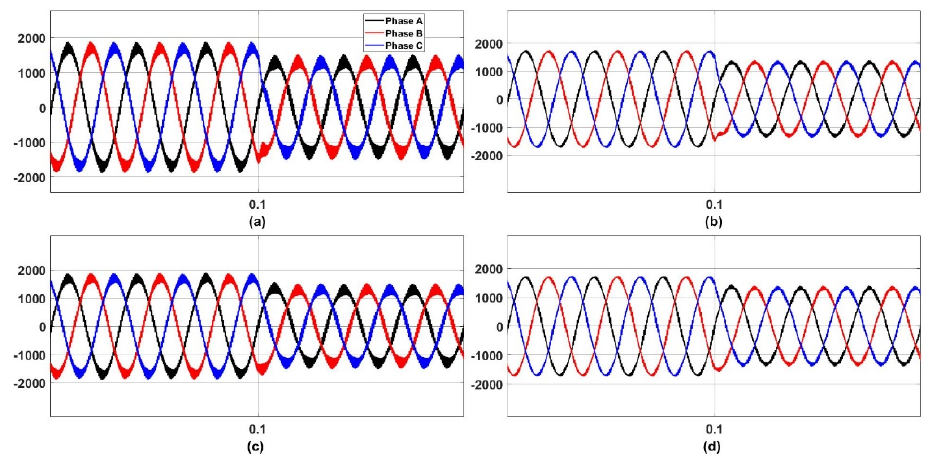
Figure 20. Three-phase pcc currents in a balanced voltage swell in the case of ( a ) 2L- αβ , ( b ) 3L- αβ , ( c ) 2L-dq and ( d ) 3L-dq .